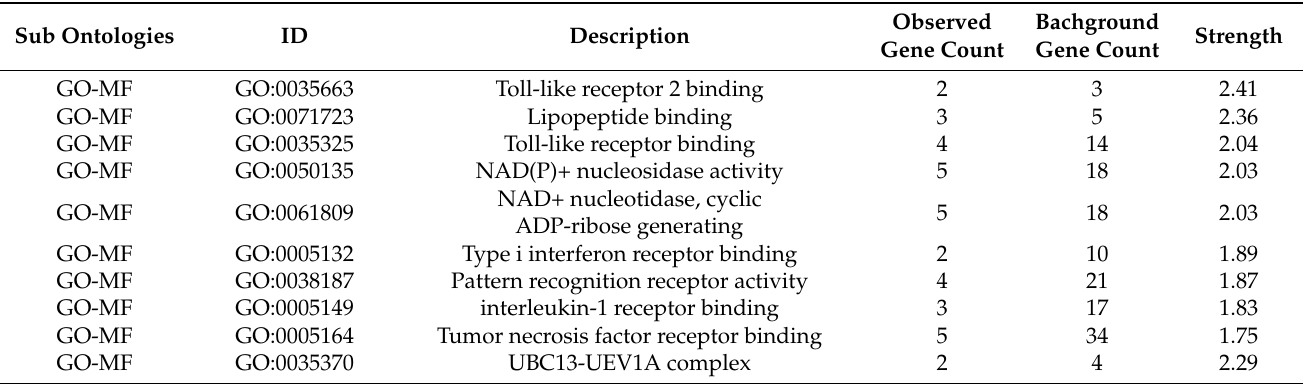
Table 4. Top 10 Enriched GO terms of the